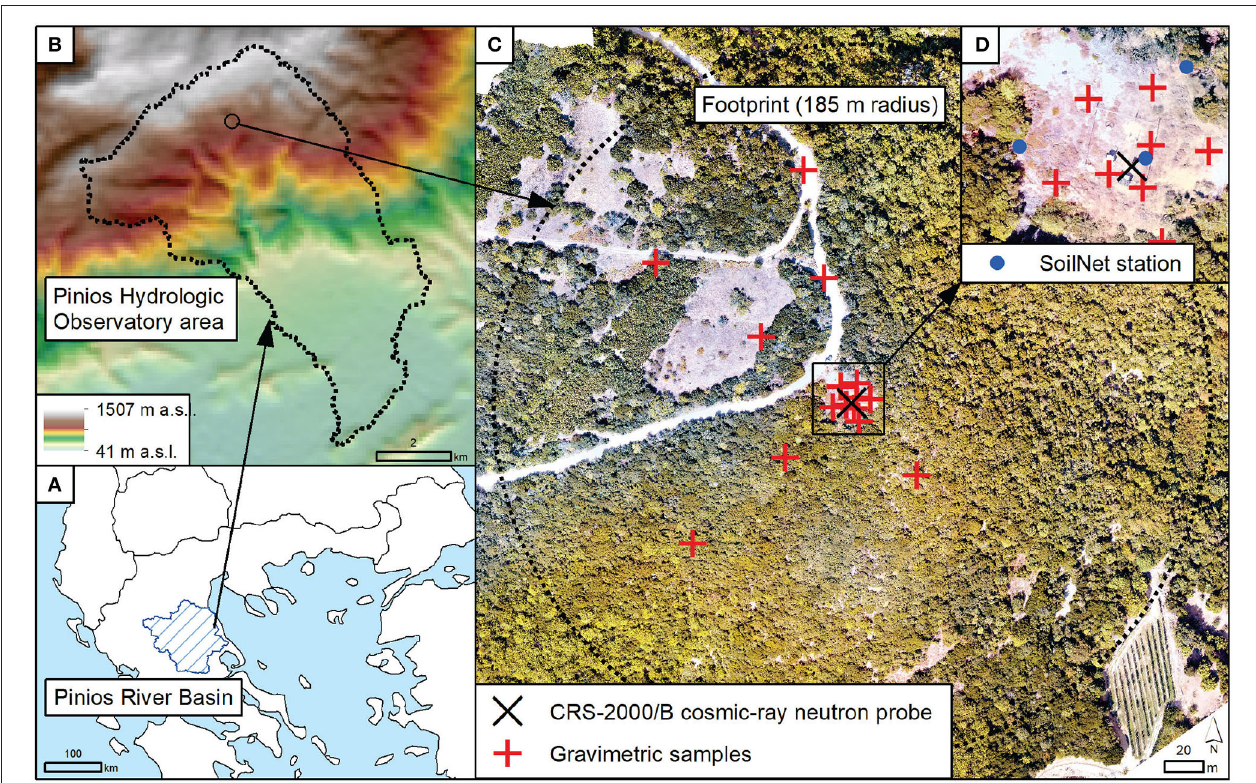
FIGURE 1 | Overview of the study area showing: (A) the extension of the Pinios River Basin, (B) the extension and topography of the Pinios Hydrologic Observatory, (C) a drone image of the CS3 test site and the footprint area of the CRNP with the locations of the gravimetric samples, and (D) the locations of the SoilNet stations.